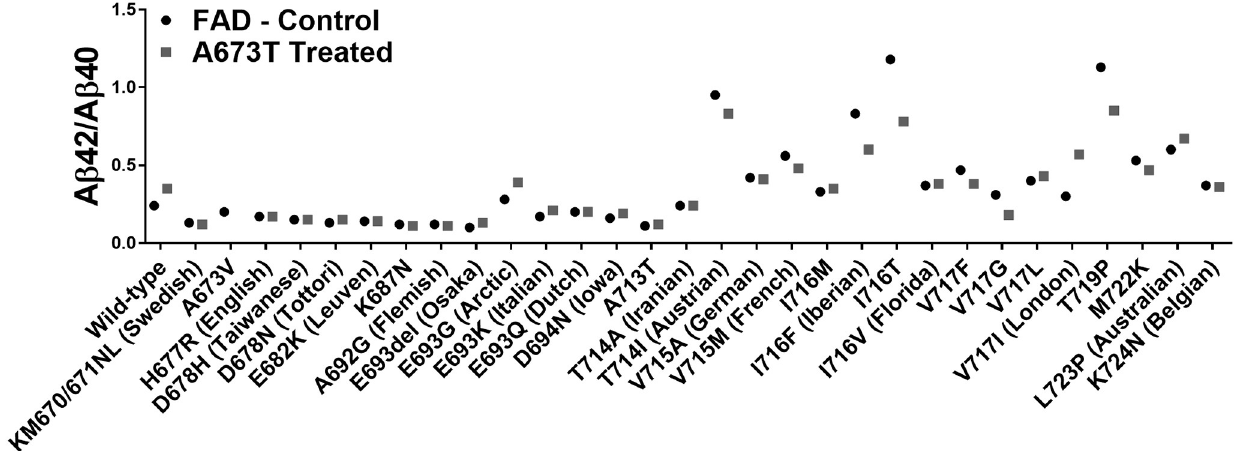
Fig 5. A β 42/A β 40ratios. Culture medium of cells transfected with plasmids coding for 30 FAD mutations with or without an additional Icelandic (A673T) mutation (except for A673V).